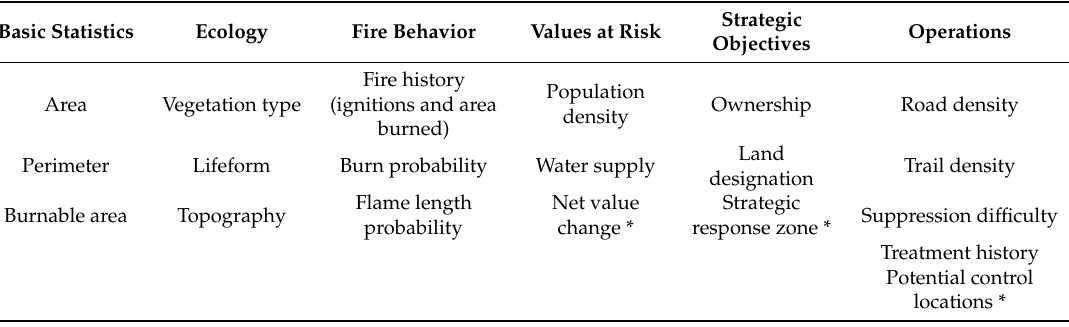
Figure 2. Prototype developed with local fire sta ff on the Arapaho–Roosevelt National Forest in Colorado, USA. Left panels show location of POD in relation to broader POD network, with di ff erent underlying reference layers. Right panel shows text-based summary information. Table 1. Common data layers extracted and summarized by the POD Summarization Tool. Asterisk (*) indicates local data available in some locations where advanced risk modeling analyses have been